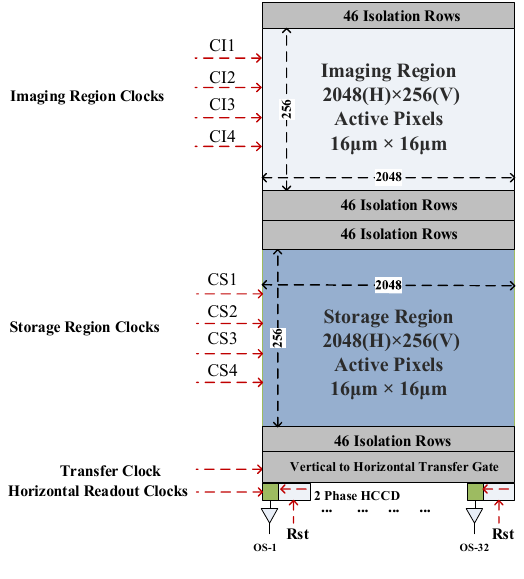
Figure 5. CCD structure diagram.